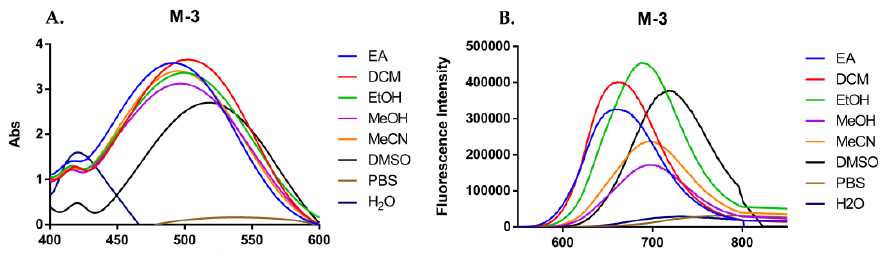
Figure 3. ( A ) UV absorption spectrum of 50 µ M M-3 in different solvents; ( B ) Fluorescence emission spectrum of M-3 in different